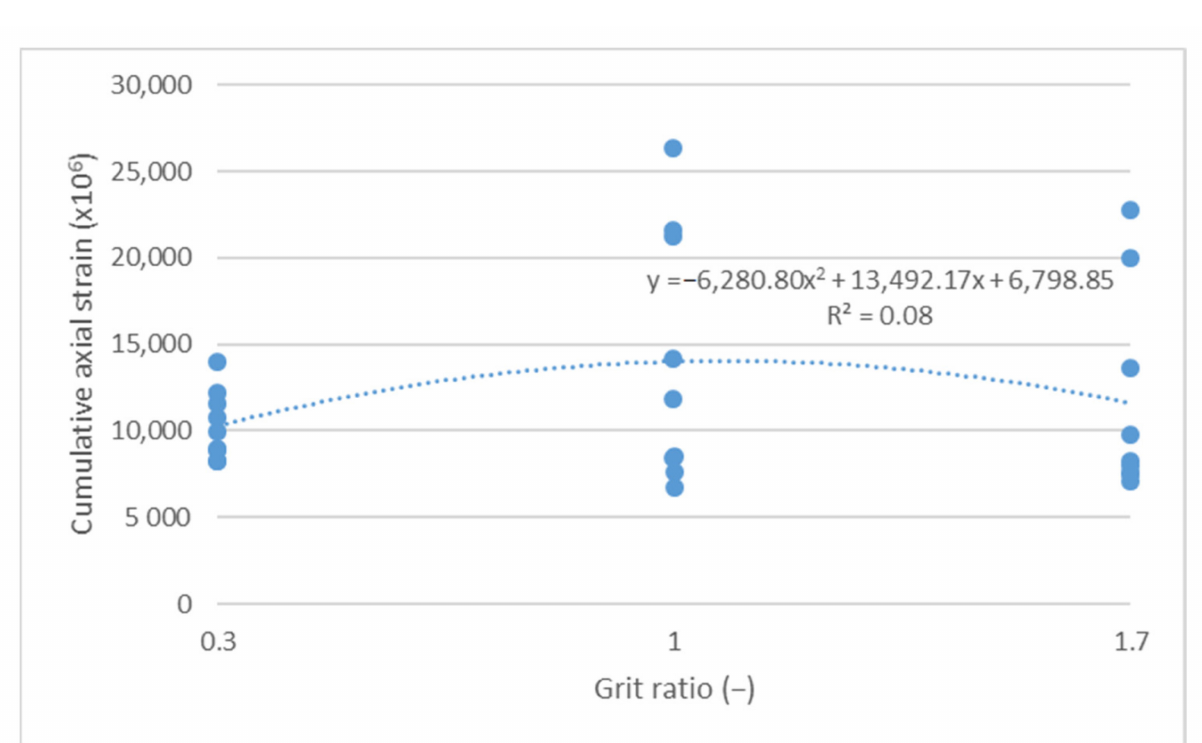
Figure 7. Cumulative axial strain vs. grit